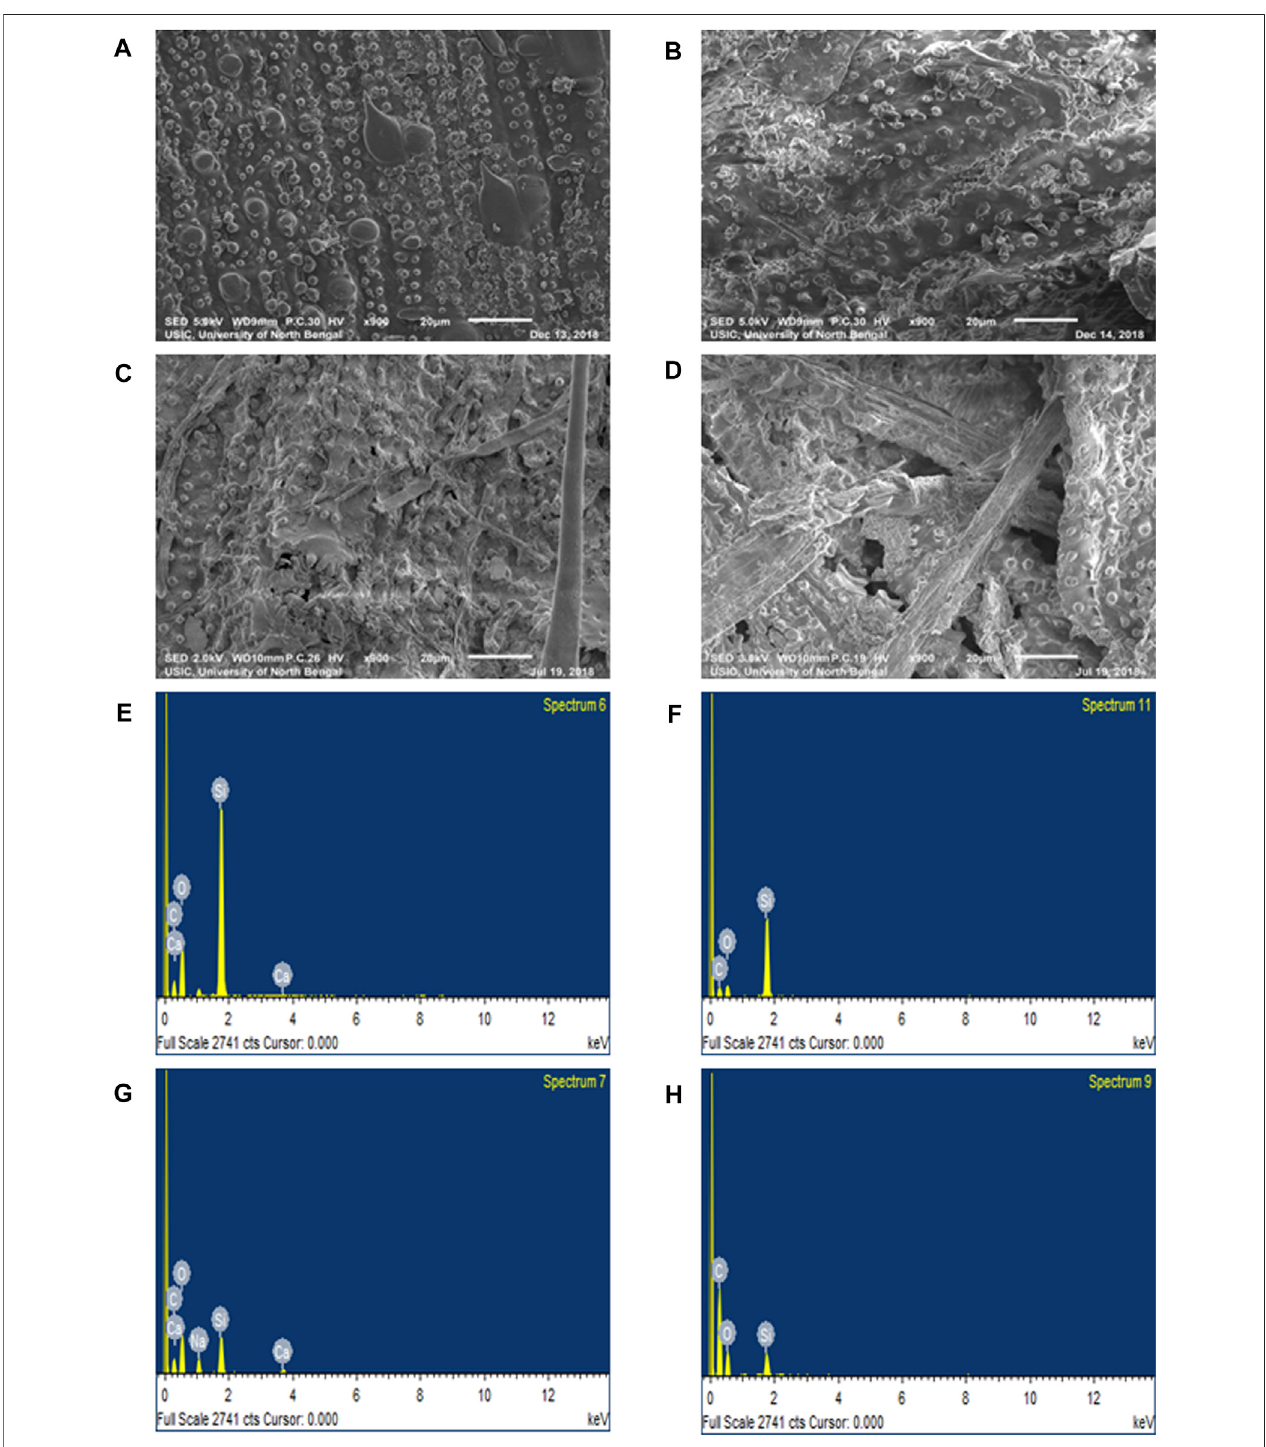
FIGURE 4 | SEM analyses (A) RS (B) SRS (C) NaOH RS (D) NaOH SRS and EDS analysis of silica percentage (E) RS (F) SRS (G) NaOH RS (H) NaOH SRS of different samples after 5 days of HTSS.